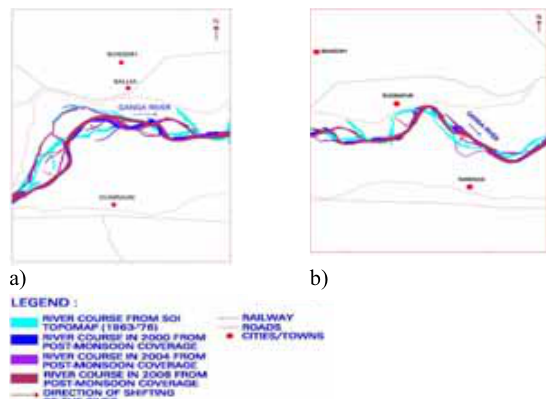
Fig 2: Shifting of the river channel a) near Ballia b) near